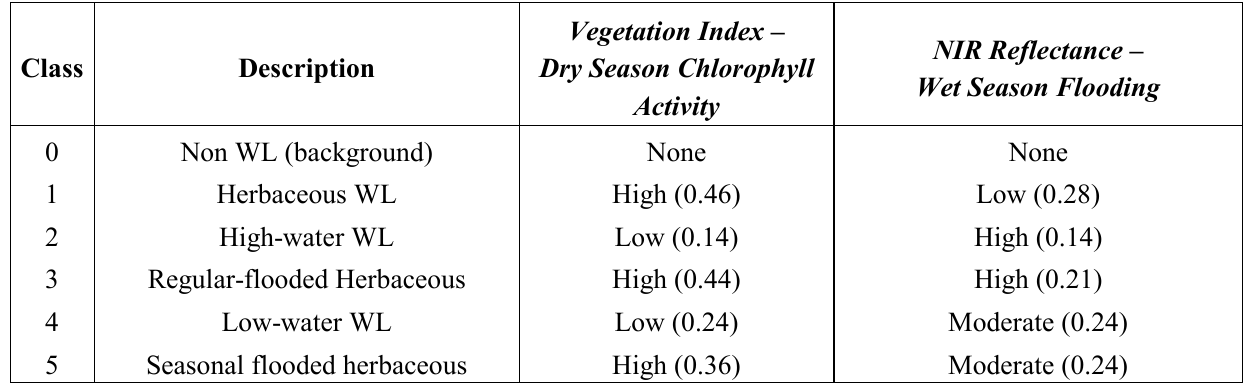
Table 1. Five wetland classes derived from the index function, their morphological descriptions, and their vegetation chlorophyll activity versus flooding levels in the wet season are shown (WL-wetland). The mean VI values and mean NIR surface reflectance associated with each descriptive class are shown in